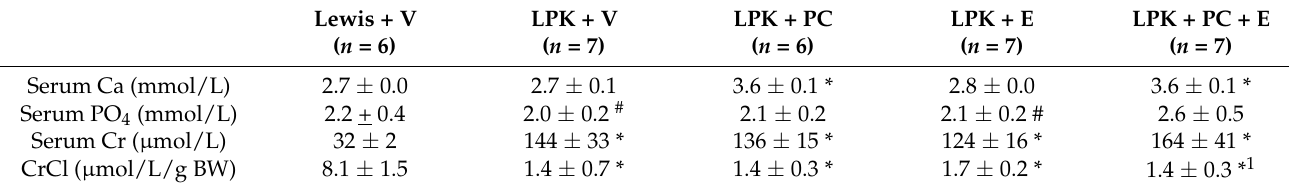
Table 3. Effect of delayed treatment of paricalcitol, enalapril and combination therapy on renal function and serum calcium in LPK rats at week